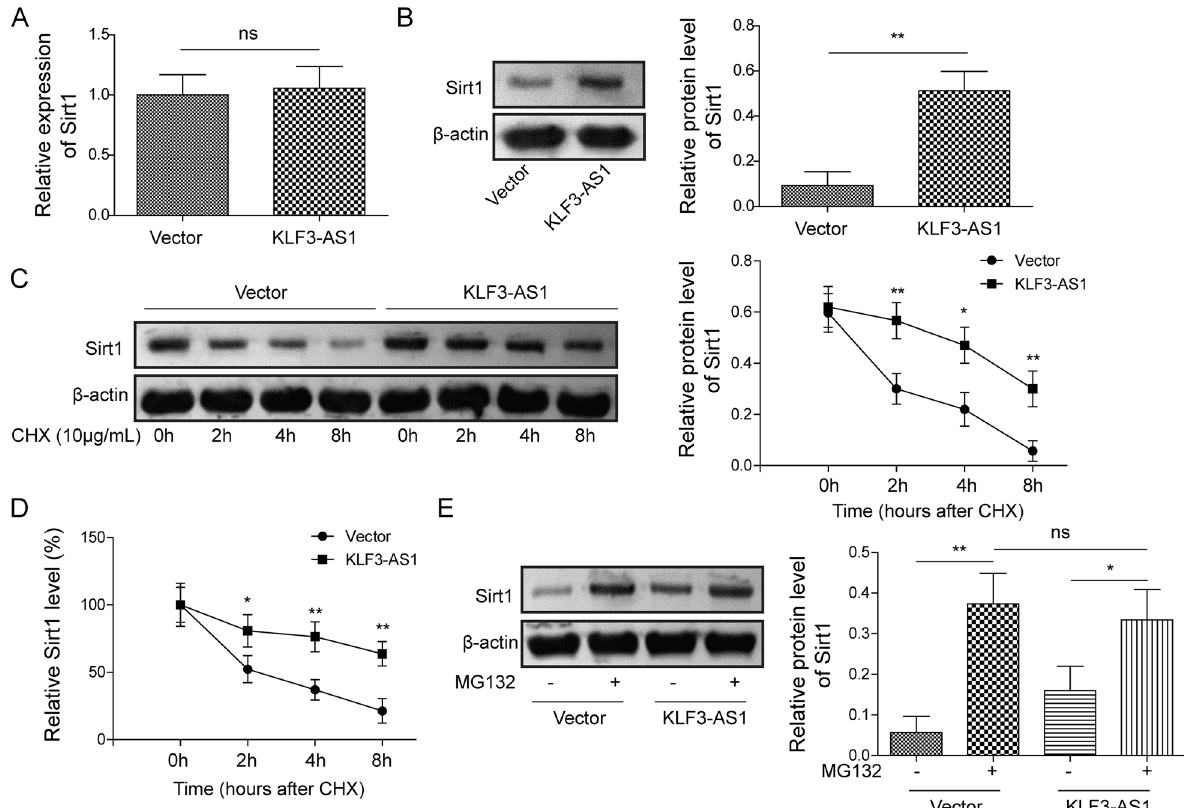
Fig. 3 The effect of KLF3-AS1 on Sirt1 protein expression and its stability. A , B Cells were treated by vector or KLF3-AS1 overexpression plasmid. Sirt1 mRNA and protein levels were determined. C , D Cells transfected with KLF3-AS1 overexpression plasmid or vector were treated with cycloheximide, and Sirt1 protein level were detected. E After transfected with KLF3-AS1 overexpression plasmid or vector, Cells were treated with MG132. And Sirt1 protein level was detected. Values were expressed as mean SD of three separate determinations in the in vitro assays. *P < 0.05, ± **P < 0.01, ***P <